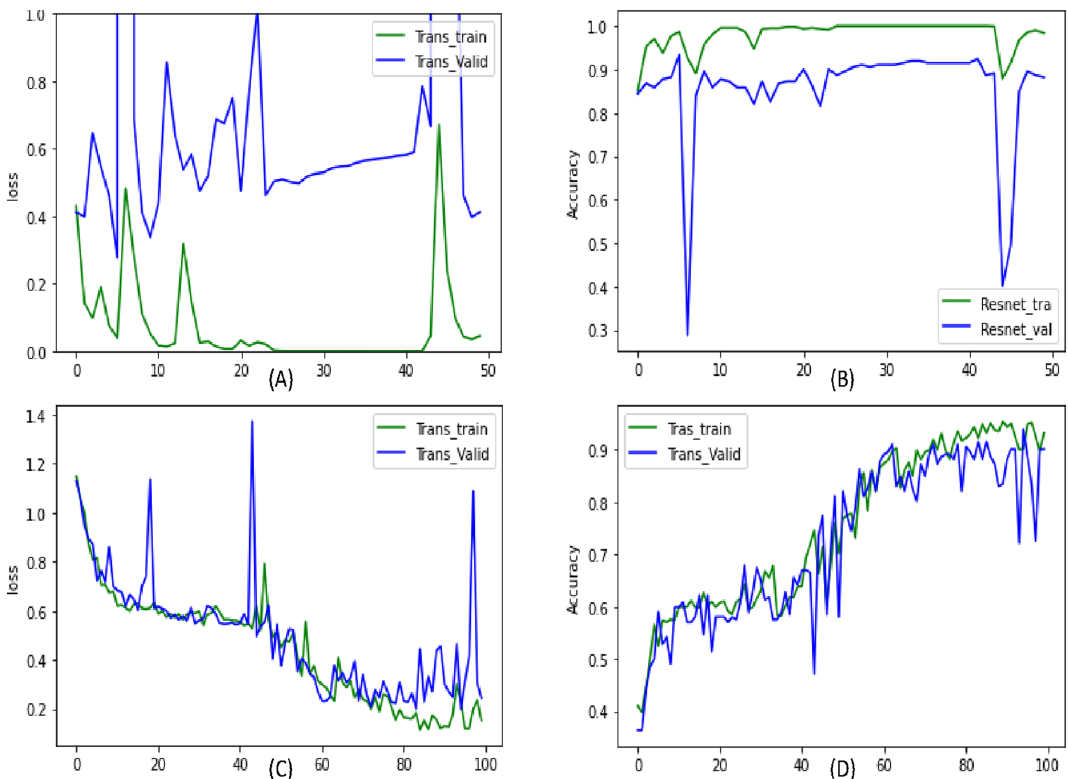
Figure 4. Graph ( A ) shows the training and validation accuracy curve for Resnet50 on our dataset. Graph ( B ) shows the training and validation loss curve for Resnet50 on our dataset. Graph ( C ) training and validation accuracy curve for VIT-32 on our dataset. Graph ( D ) shows the training and validation loss curve for VIT-32 on our dataset. In all the graphs, the x-axis shows the number of epochs.